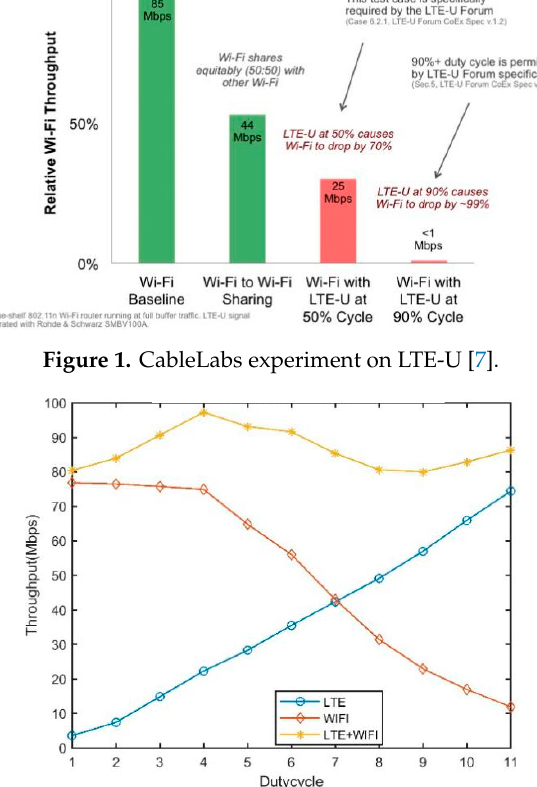
Figure 2. Preliminary simulation results of duty cycle LTE-U.